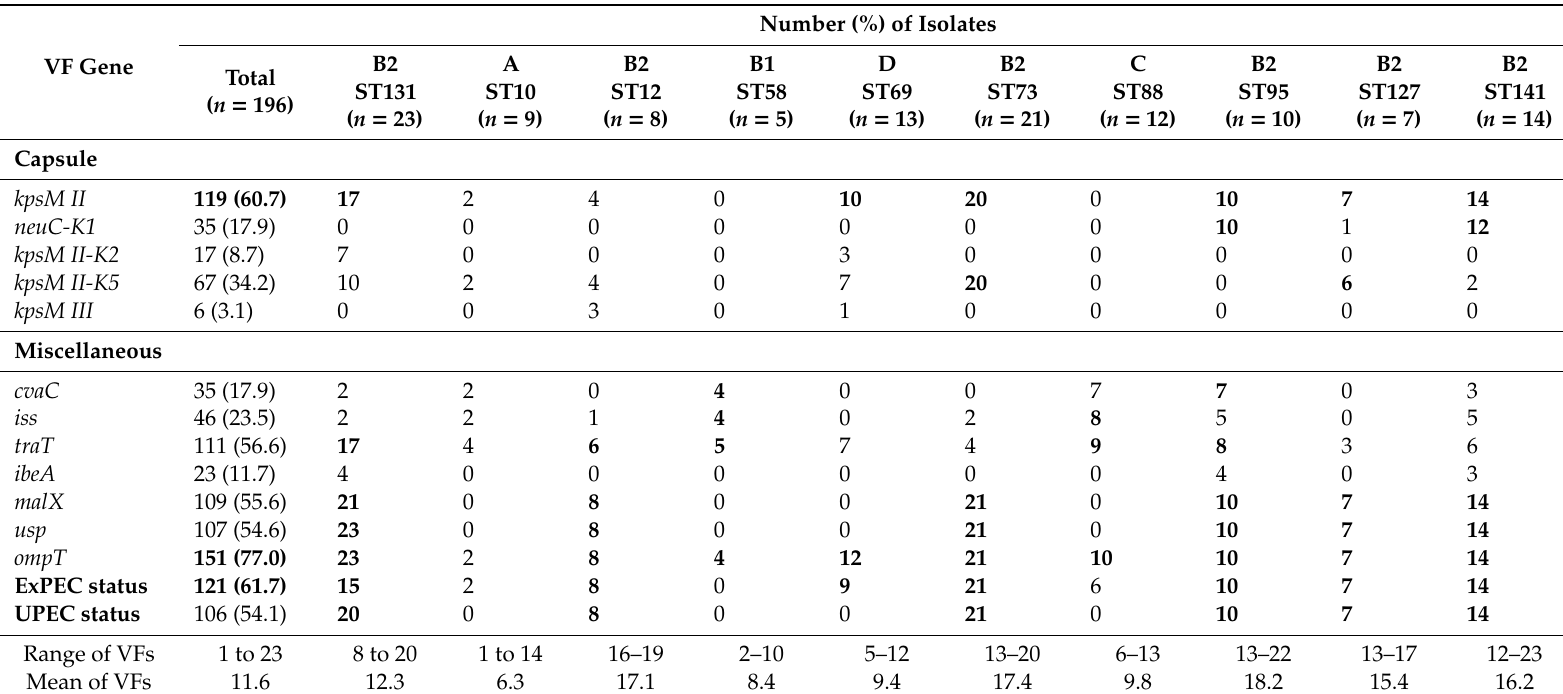
Bold indicates the VF-encoding gene present in ≥ 60% of the